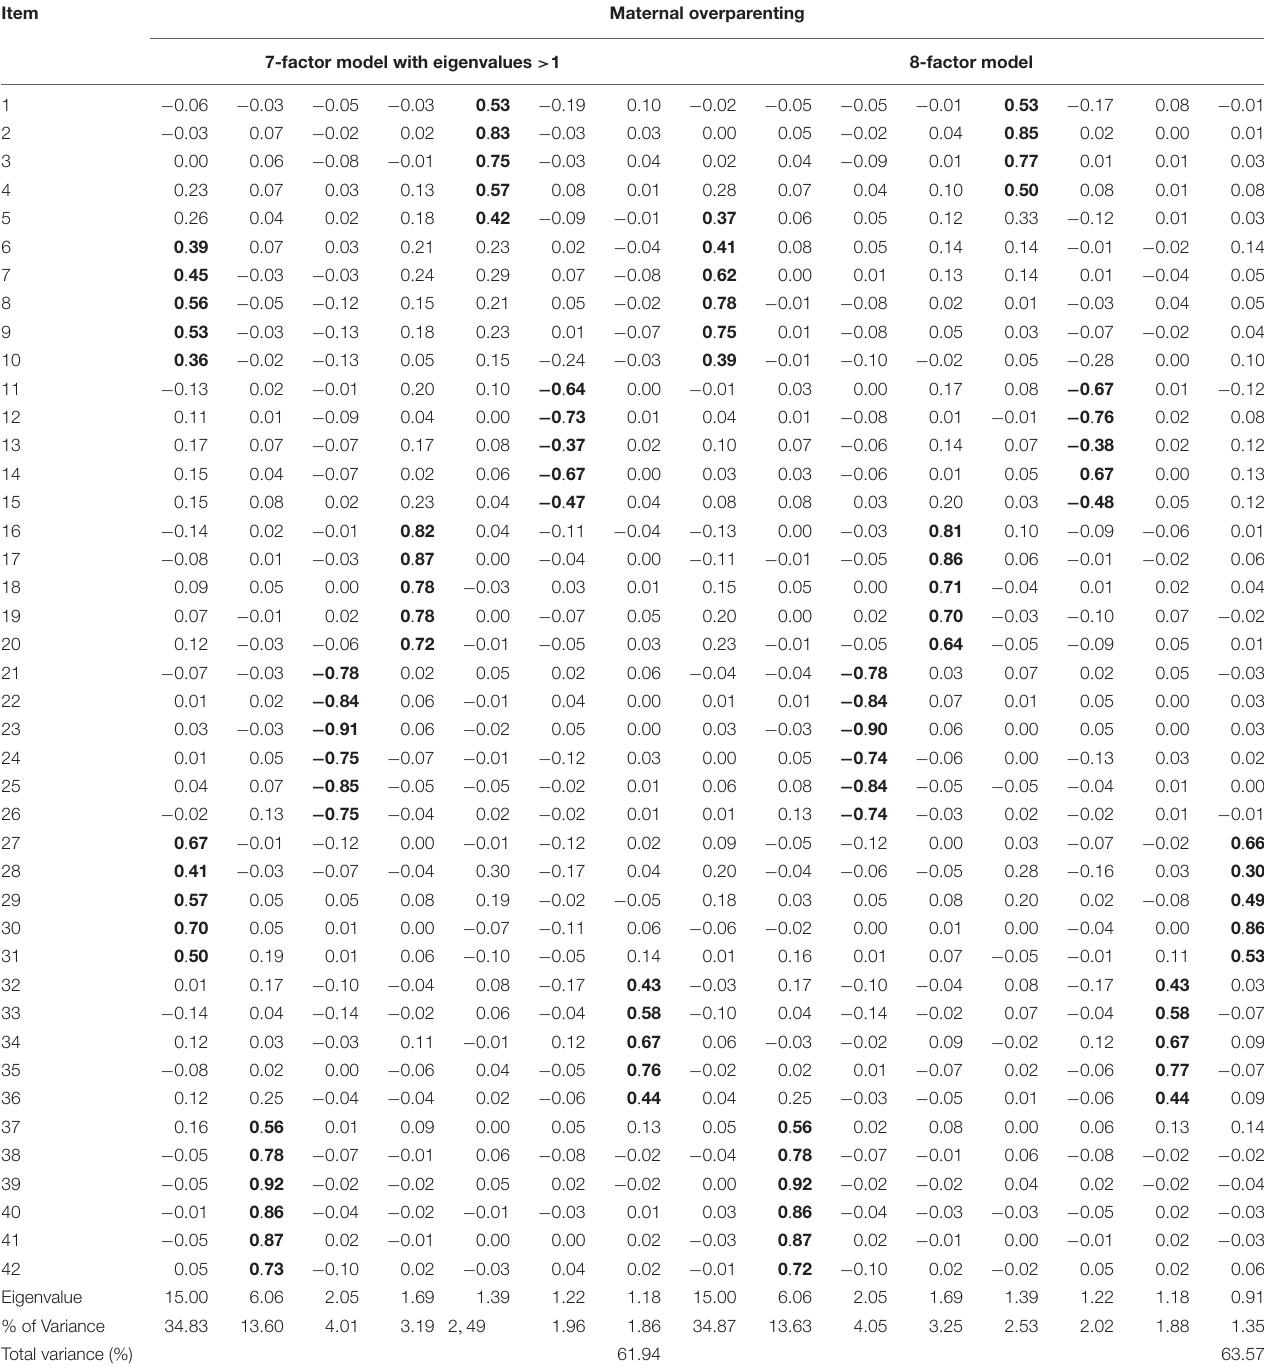
TABLE 4 | Exploratory factor analyses models of Chinese Maternal Overparenting